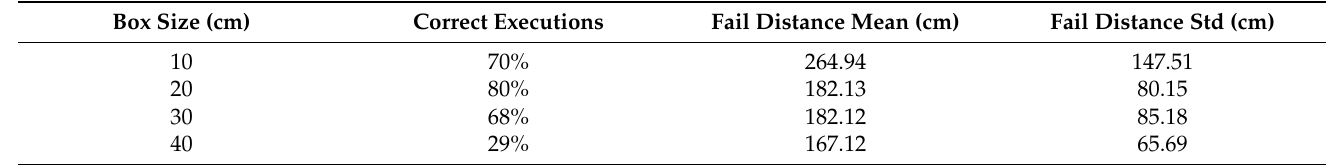
Table 3. Policy tests for different square box sizes. For each size, 100 executions of the behavior were carried out. If the box did not reach the goal in 700 iterations, then the test was marked as incorrect. For all incorrect tests of each size, the box–goal mean distance and standard deviation are